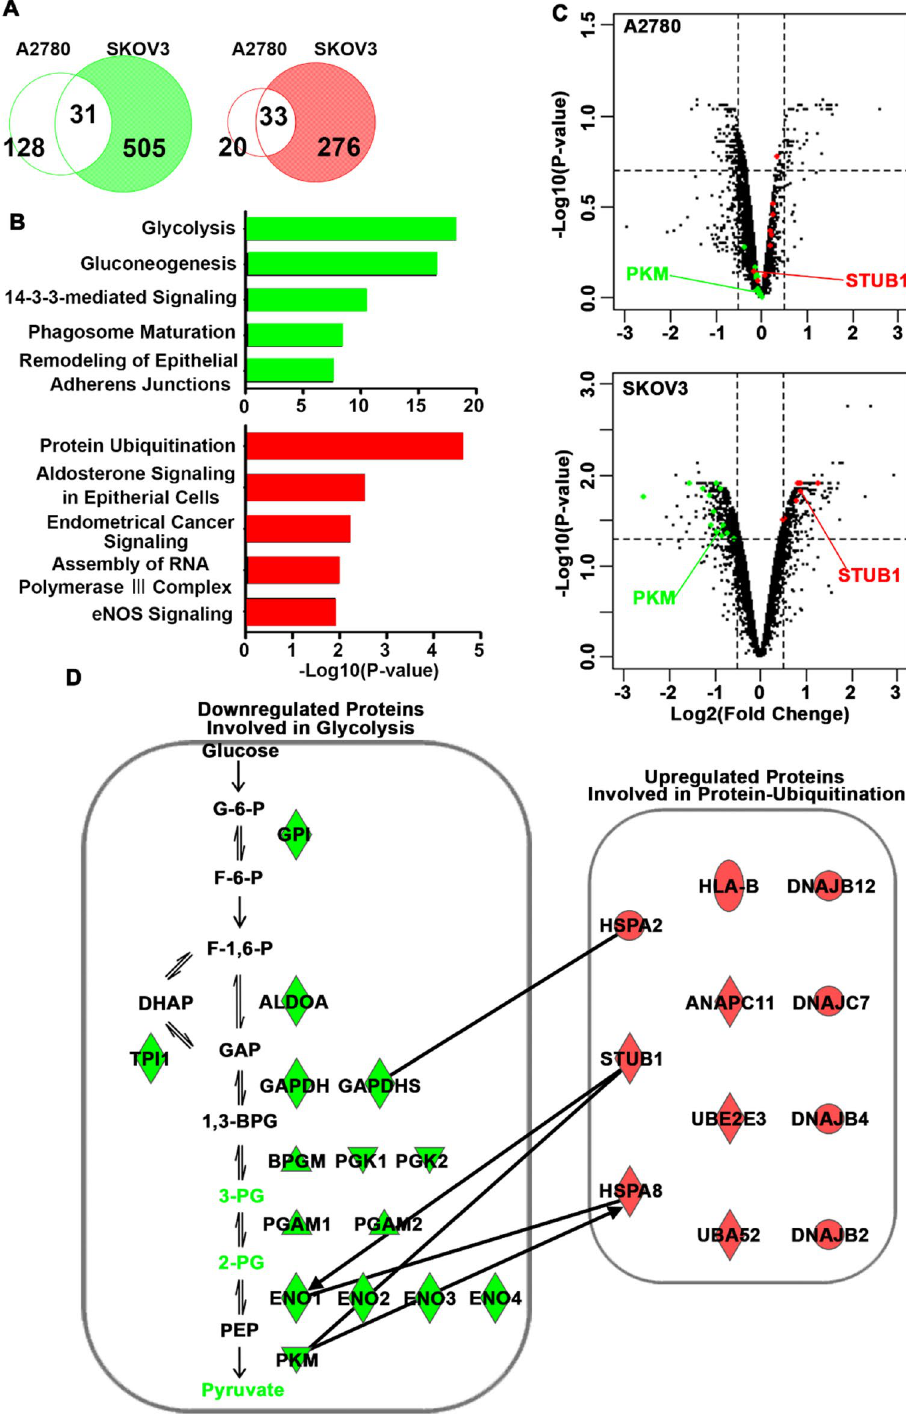
Figure 2. Detailed proteomics analysis of heated SKOV3 cells. ( A ) Venn diagrams of downregulated proteins (left) and upregulated proteins (right) in A2780 and SKOV3 cells after hyperthermia. Data were adapted from Hatakeyama H 8 . ( B ) Graphs show the top five enriched GO annotations for biological processes for differentially expressed downregulated proteins (upper) and upregulated proteins (lower) in SKOV3 cells. ( C ) Volcano plots of differentially expressed proteins in A2780 (upper) and SKO3 (lower) cells after hyperthermia. Proteins associated glycolysis and protein ubiquitination were represented as green and red dots. ( D ) Potential connections between glycolysis-related and ubiquitination-related proteins. Red and green indicate upregulation and downregulation, respectively. The lines indicate binding of two gene products, and lines terminating with arrows indicate one gene product acting on another gene